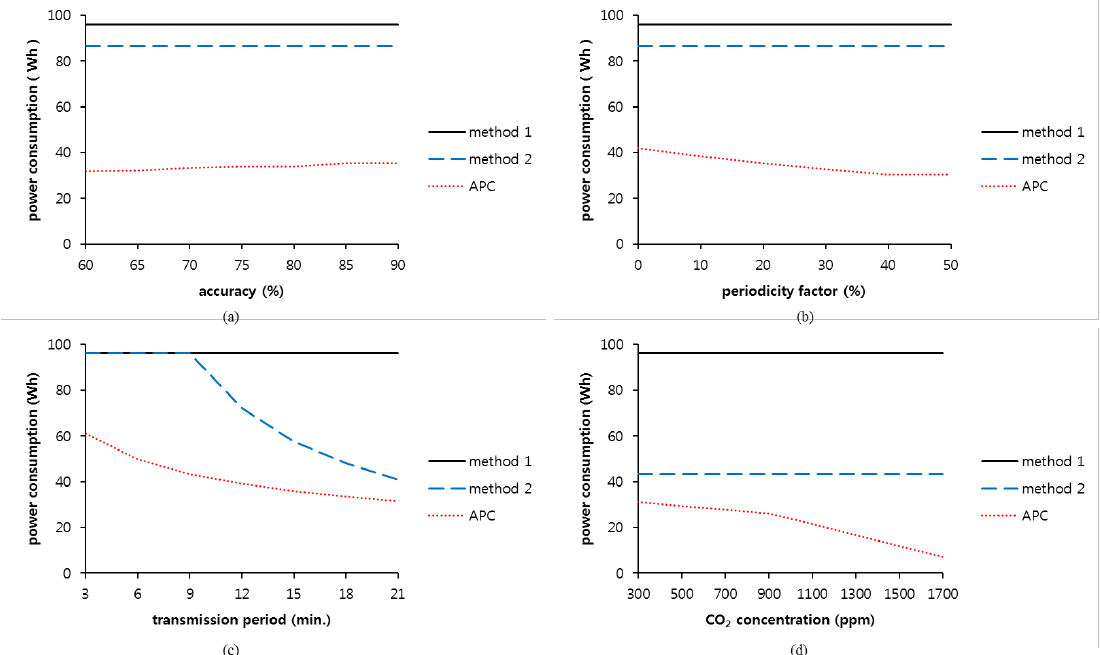
Figure 7. Comparison of the power consumption vs. ( a ) accuracy; ( b ) periodicity factor; ( c ) transmission period and ( d ) concentration of carbon